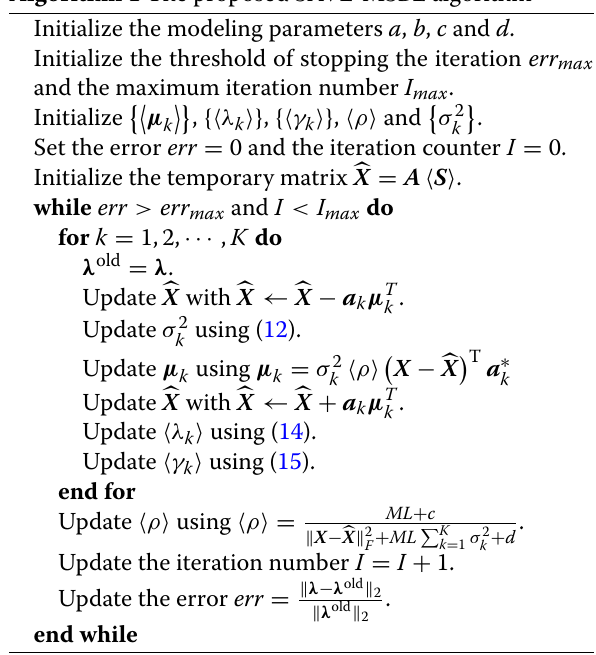
Algorithm 1 The proposed SAVE-MSBL